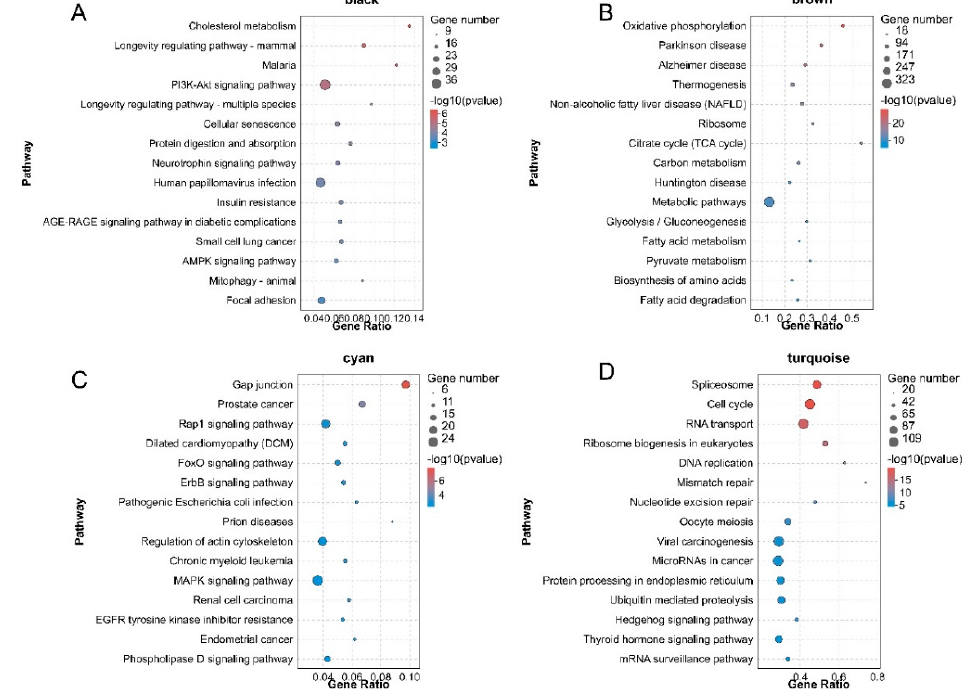
Figure 5. Bubble plots of the KEGG pathway enrichment of DEGs in the four pigeon skeletal muscle − related modules. ( A – D ) represent KEGG pathway enrichment analysis of DEGs in black, brown, cyan and turquoise modules. Colours from red to blue indicate p − value from small to large. The bubble size indicates the number of DEGs included in each biological process.